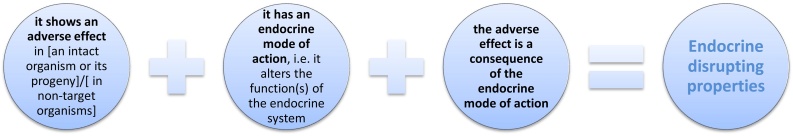
Scientific criteria for the determination of endocrine disrupting properties under the Biocidal (EU; 2017/2100) and Plant Protection Products (EU; 2018/605) Regulations as established by the European Commission. The criteria are based on the IPCS/WHO definition of an endocrine disruptor and state that “a substance shall be considered as having endocrine disrupting properties that may cause adverse effects in humans/or non-target organisms if, […], it is a substance that meets all of the following criteria, unless there is evidence demonstrating that the adverse effects identified are not relevant to humans/at the (sub)population level for non-target organisms.(1) it shows an adverse effect in an intact organism or its progeny / in non-target organisms, which is a change in the morphology, physiology, growth, development, reproduction or life span of an organism, system or (sub)population that results in an impairment of functional capacity, an impairment of the capacity to compensate for additional stress or an increase in susceptibility to other influences;(2) it has an endocrine mode of action, i.e. it alters the function(s) of the endocrine system;(3) the adverse effect is a consequence of the endocrine mode of action.